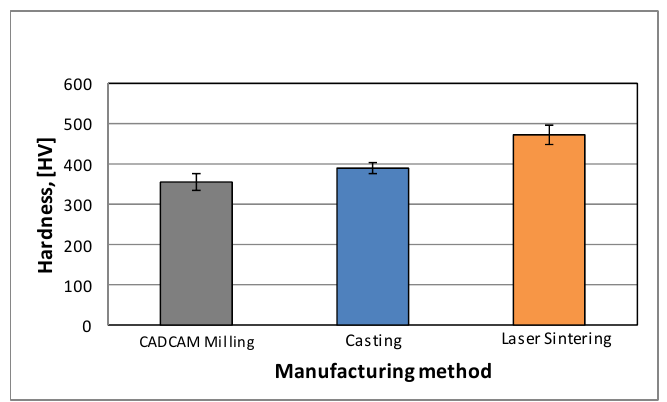
Figure 8. Microhardness (HVN) for the samples obtained with different methods.